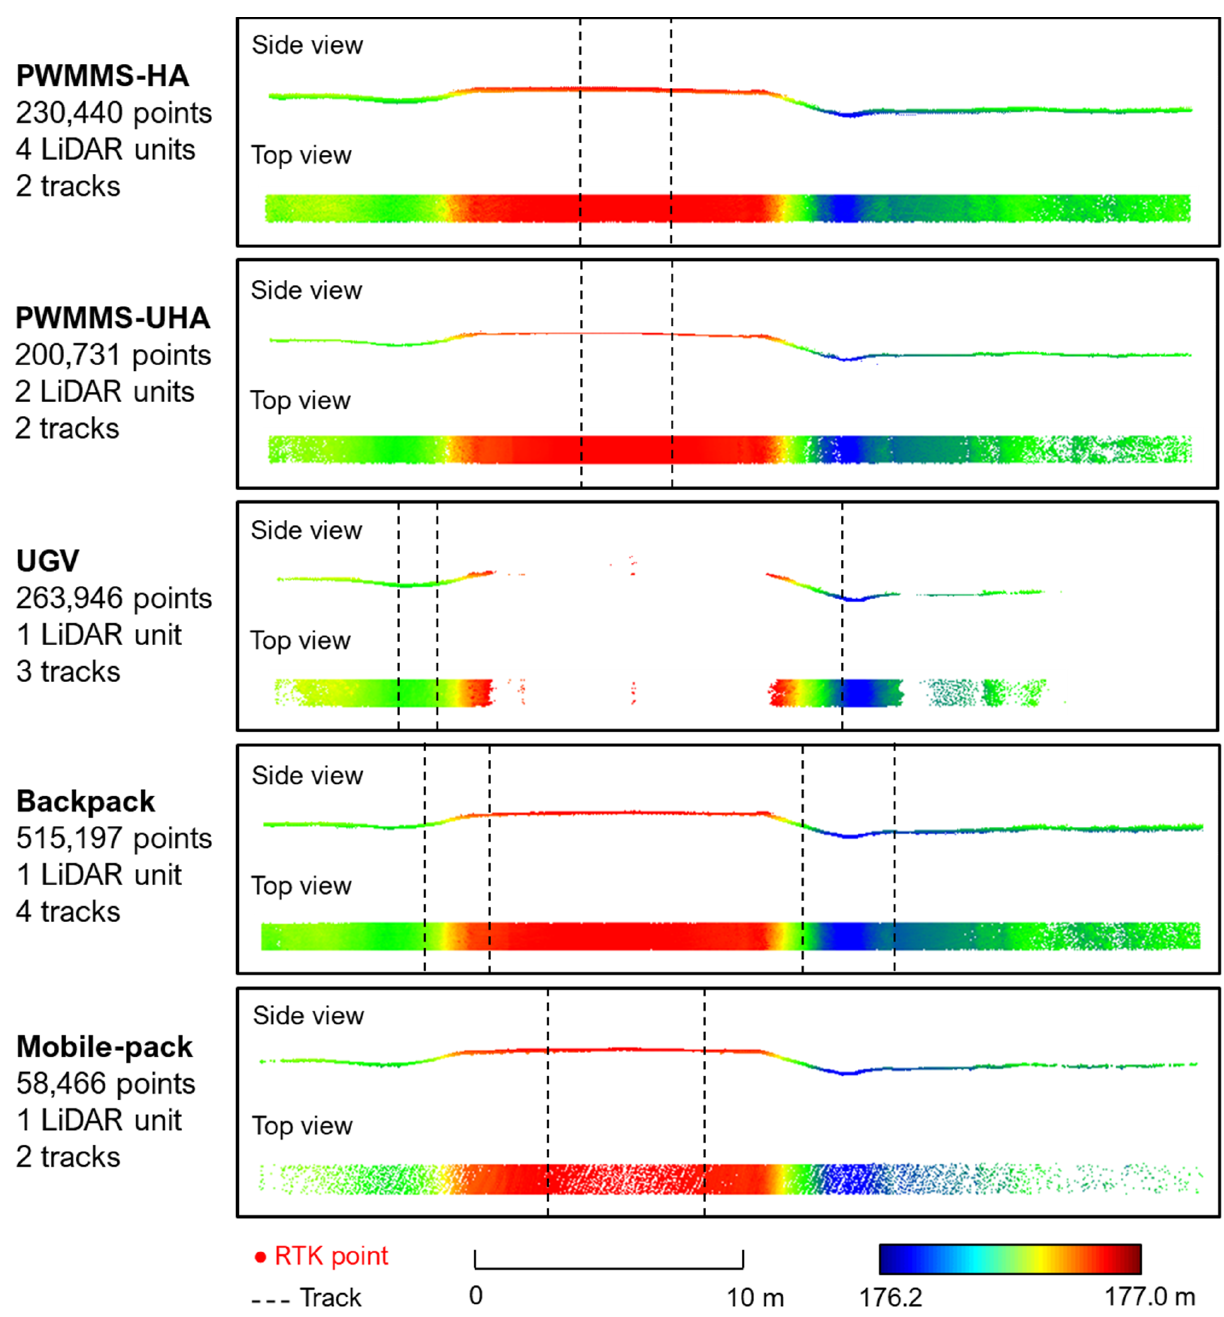
Figure 13. Cross-sectional profiles at location PB3 from different systems showing the side view, top view, and the platform tracks (black dashed lines).